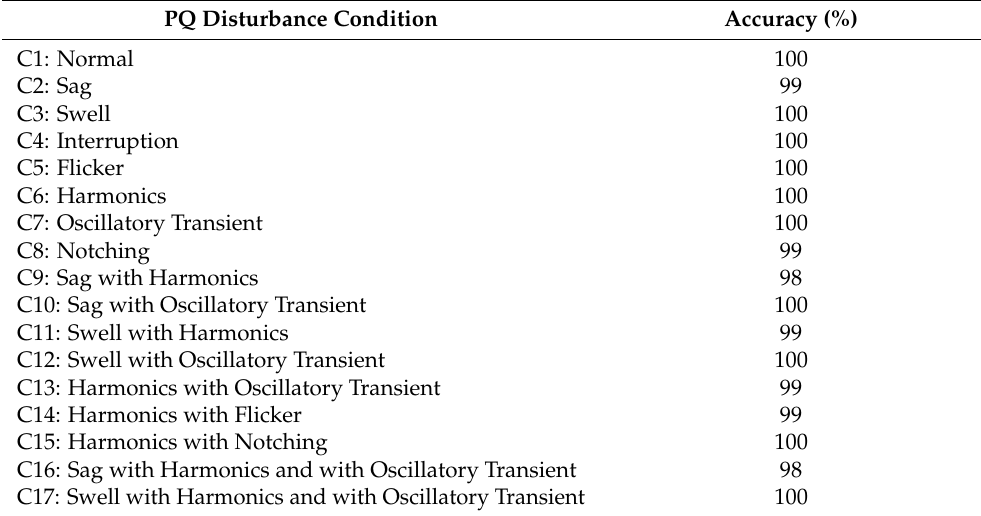
Table 2. Classification accuracy of PQ disturbance conditions applying the stacked autoencoder- neural network